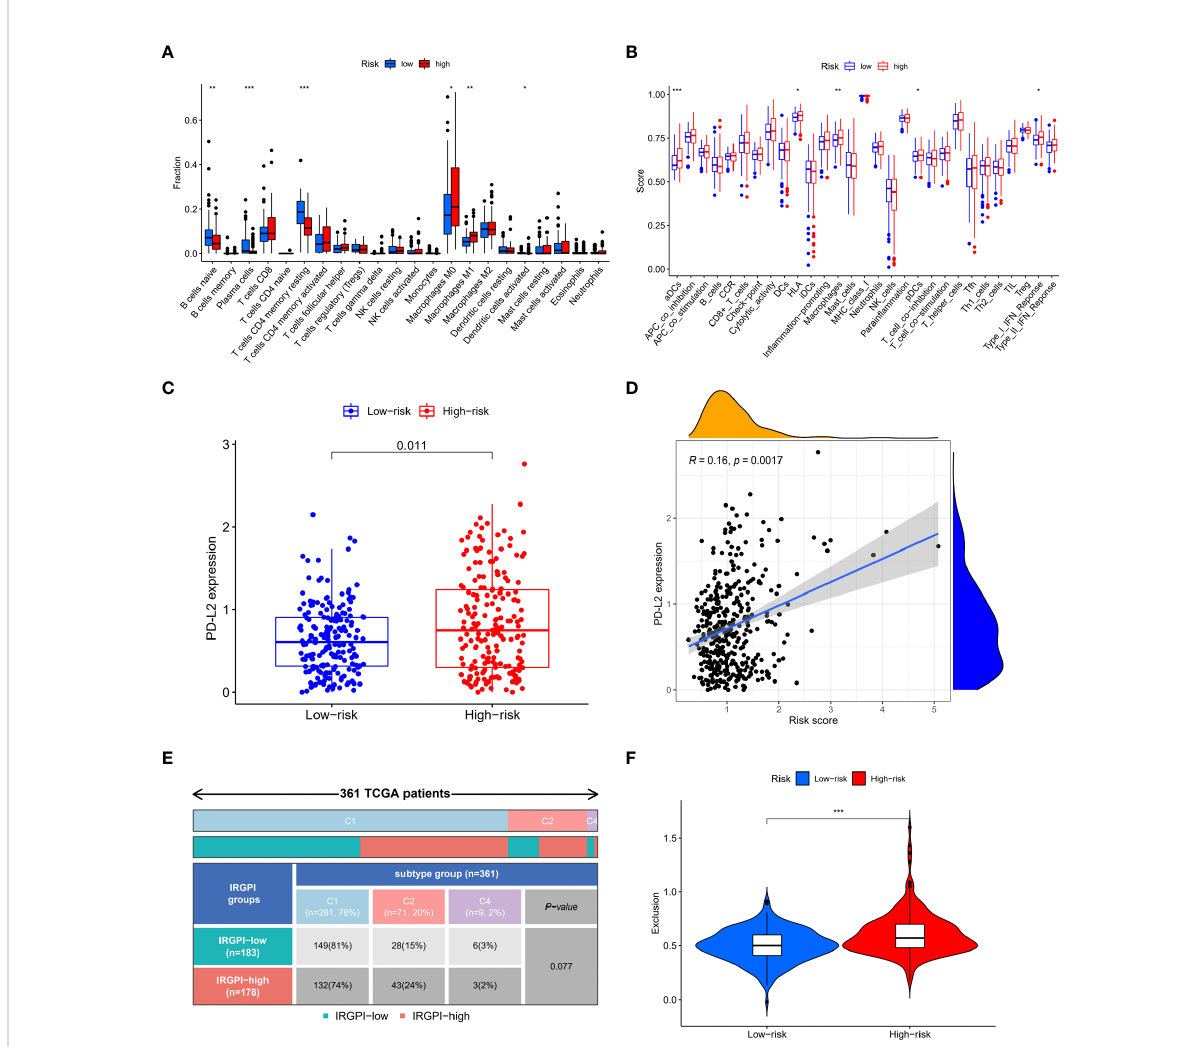
FIGURE 5 Correlation of IRGPI with immune features. (A) Immune cell in fi ltrations in high-risk and low-risk patients. High-risk group patients had higher in fi ltration level of M0 macrophages, M1 macrophages and lower in fi ltration level of naïve B cells, plasma cells and resting CD4+ memory T cells. (B) Immune function score in high-risk and low-risk patients. High-risk group had higher aDCs, HLA, macrophages, pDCs and type I IFN-response. (C) PD-L2 expression in high-risk and low-risk patients. PD-L2 expression was higher in high-risk group (D) Spearman correlation analysis of the correlation between PD-L2 and IRGPI. PD-L2 expression was positively related to IRGPI (E) Immune subtypes in high-risk and low-risk patients. No signi fi cant difference was observed in the proportion of each immune subtype between the high-risk and low-risk groups. (F) Immune exclusion score in high-risk and low-risk patients. Immune exclusion score was higher in high-risk group. *p<0.05; **p<0.01;